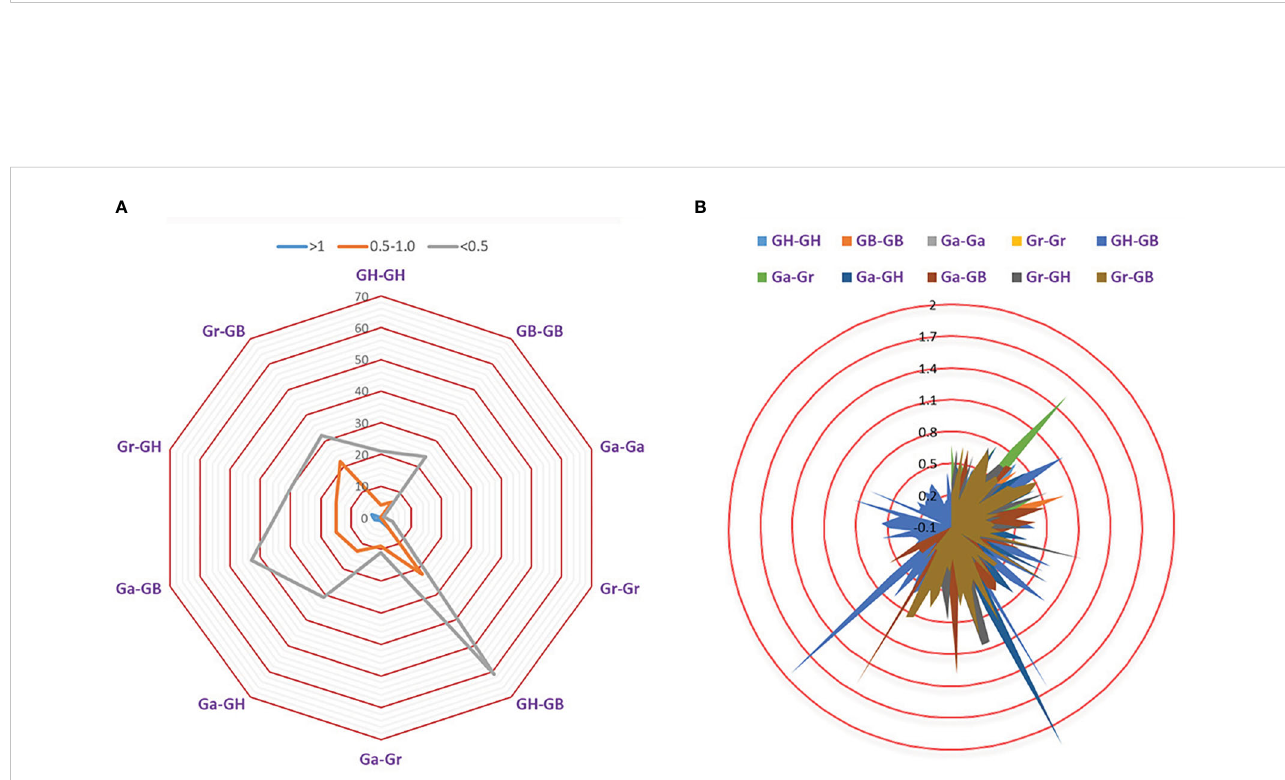
FIGURE 6 Selection pressure of TPS gene family. (A) The number of duplicate genes with different Ka/Ks values. (B) Ka/Ks divergence values of different